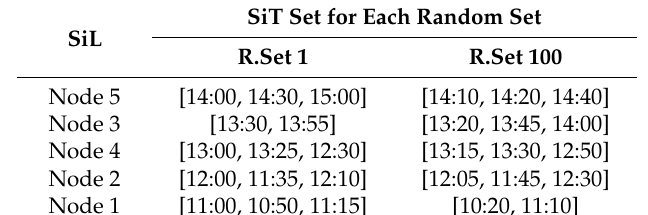
Table 3. Output results from the spatial filter of the sample network. SiT Set for Each Random Set SiL R.Set 1 R.Set 100